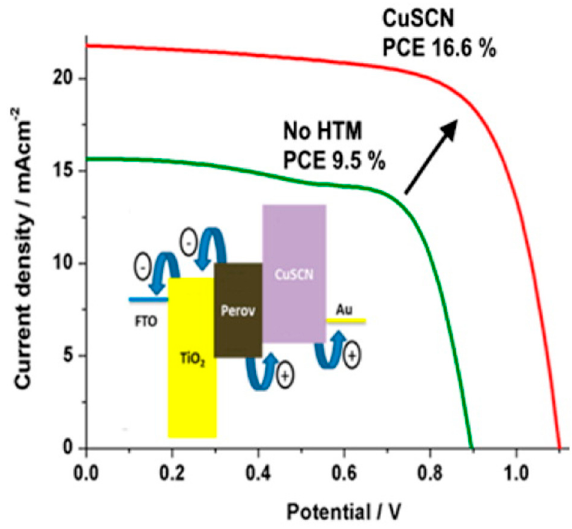
Figure 22. Current-voltage curves for PSC with copper thiocyanate (CuSCN) HTM and without any HTM (reproduced with permission from [148], published by the American Chemical Society).